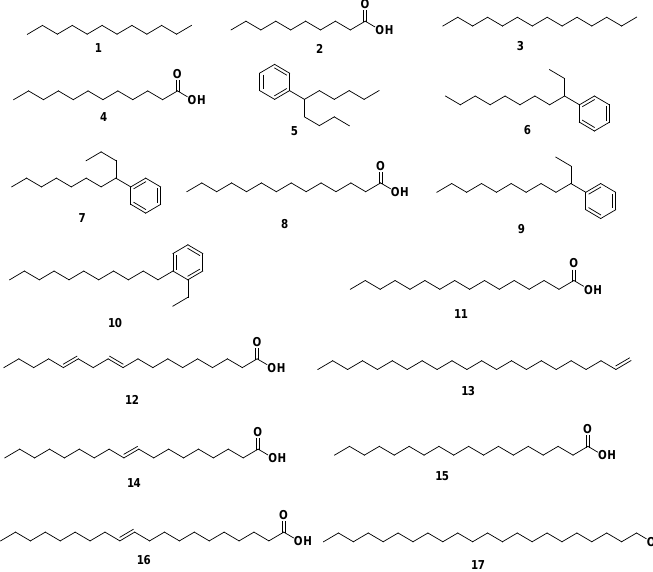
Figure 2. Structures of identified compounds from coconut seed oil by GC/MS analysis.